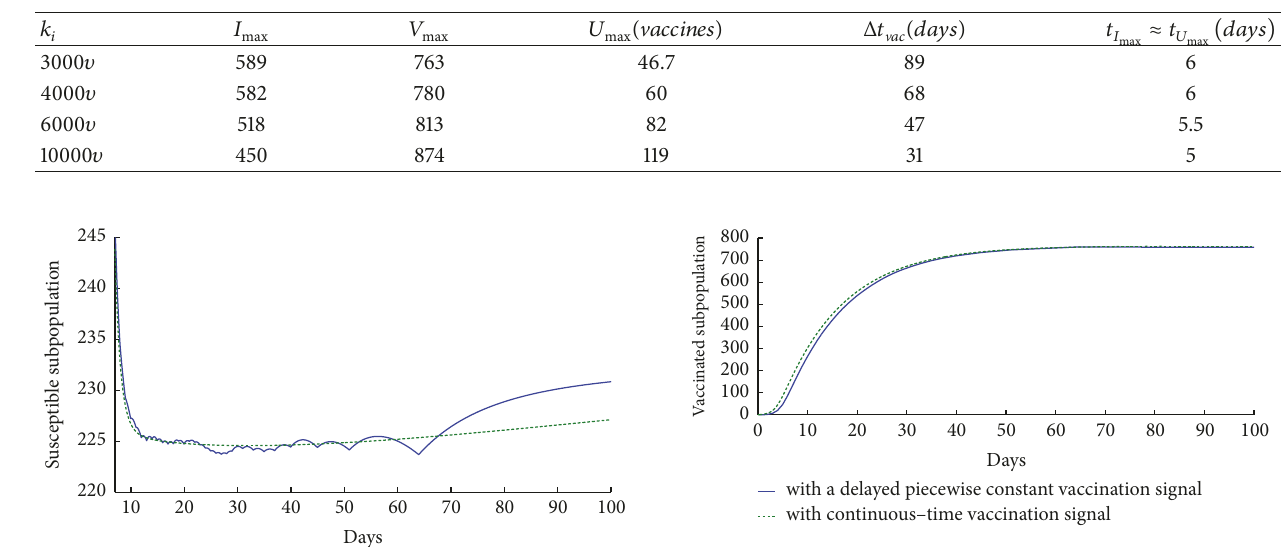
Figure 19: Vaccinated subpopulation in the SISV model with two different vaccination signals: (i) a delayed piecewise constant signal taking integer values and (ii) continuous-time signal.